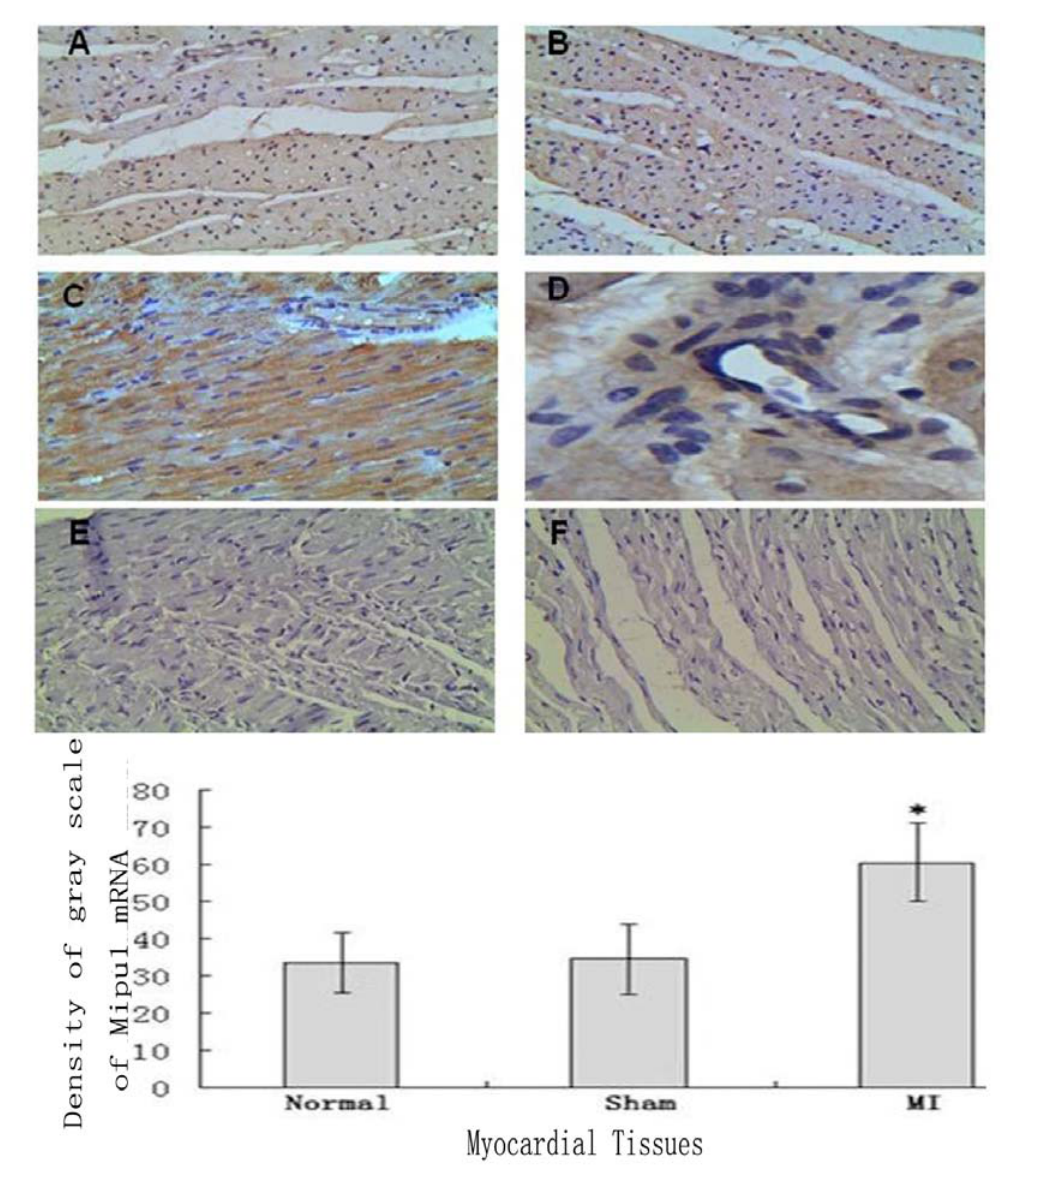
Figure 3. In situ hybridization analysis of Mipu1 mRNA in infarct endothelium and myocardium. A: Normal heart; B: Sham heart; C: Infracted myocardium; D: Blood vessels in the infracted myocardium; E: Negative control of normal heart; F: Negative control of infracted myocardium (200×). * vs Normal, P < 0.05,